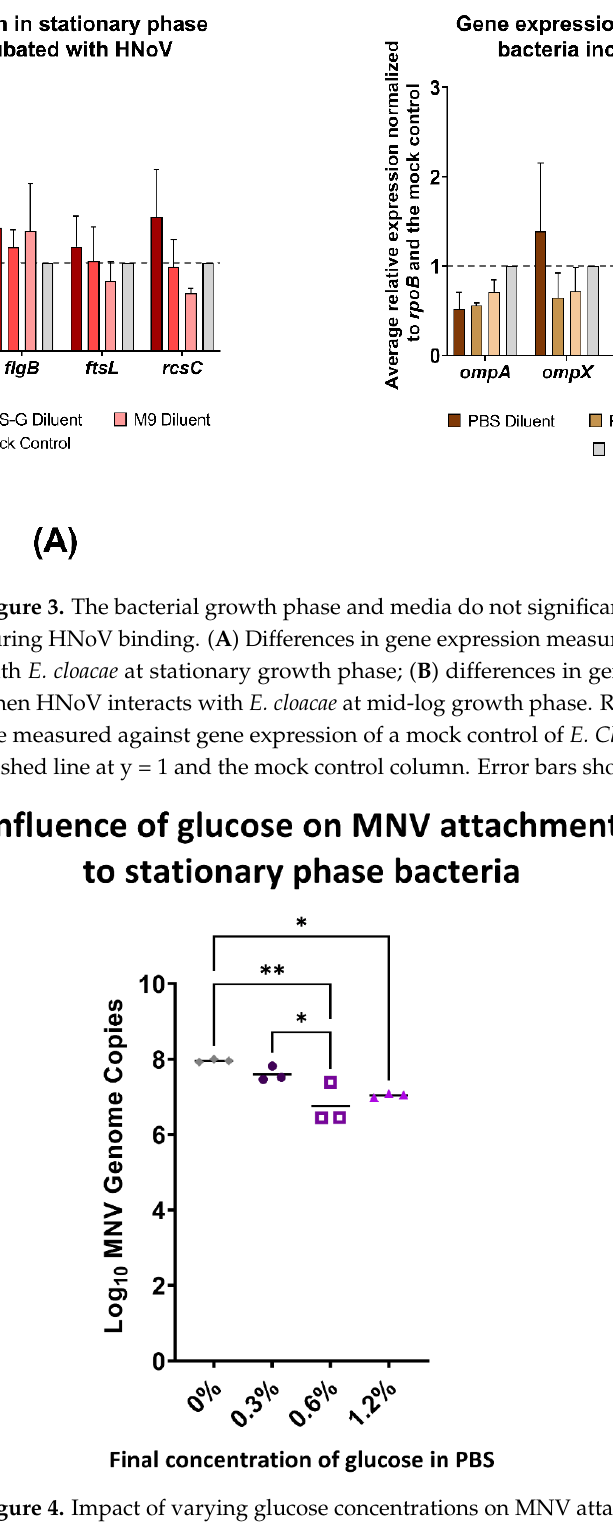
Figure 4. Impact of varying glucose concentrations on MNV attachment to E. cloacae. MNV genome copies were measured using RT-qPCR after 1 h of viral attachment to E. cloacae in PBS only (0% glucose) or PBS-G mediums with 0.3%, 0.6%, or 1.2% glucose. The attachment was assessed using E. cloacae in the stationary phase. * designates an adjusted p - value of ≤0.05, ** designates an adjusted p -value of ≤0.005; n = 3.